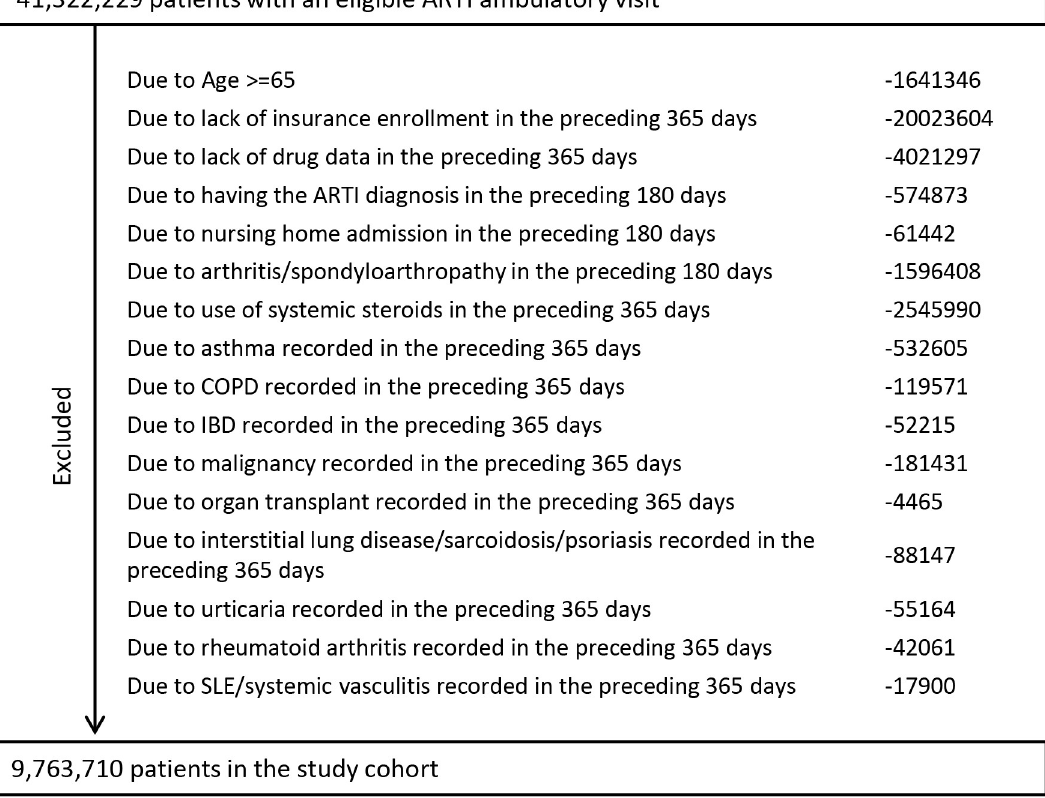
Individual comorbidities negatively associated with odds of systemic steroid prescribing were diabetes, kidney dysfunction, liver disease, dementia, venous thromboembolism, major bleed- ing events, GERD, bronchiectasis, urinary tract infections, HIV/AIDS, and bronchiectasis. associated with a lower odds of receiving systemic steroids. Use of antibiotics, proton-pump inhibitors, antiplatelets, and nonsteroidal anti-inflammatory drugs were positively associated with odds of systemic steroid prescribing (Table 2).